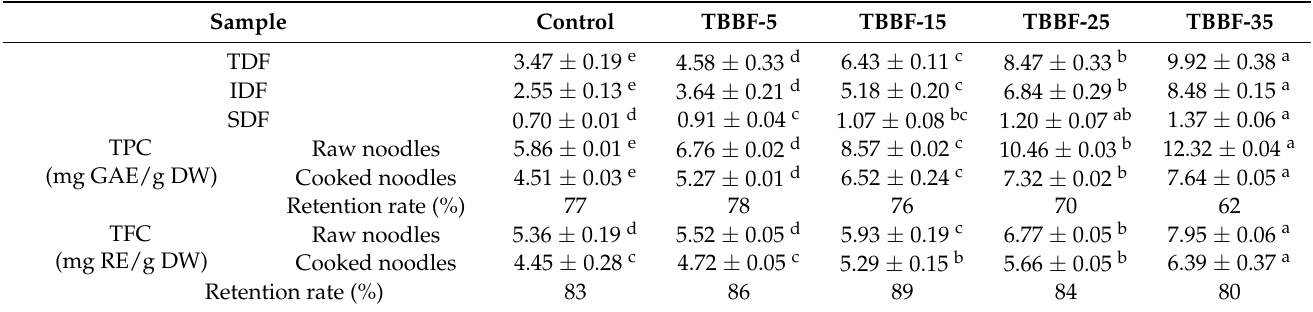
Table 3. Effect of TBBF substitution on the bioactive compounds content of